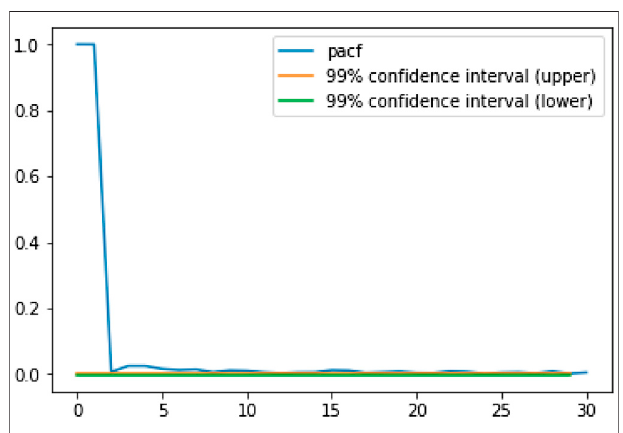
FIGURE4| ThePACF ofthetick-by-tick VWAPofESU6over the month of August 2016. sigmoid activation functions are used for all other gates. The AlphaRNN and AlphatRNN classes are implemented by the authors for use in Keras. Statefulness is always disabled.